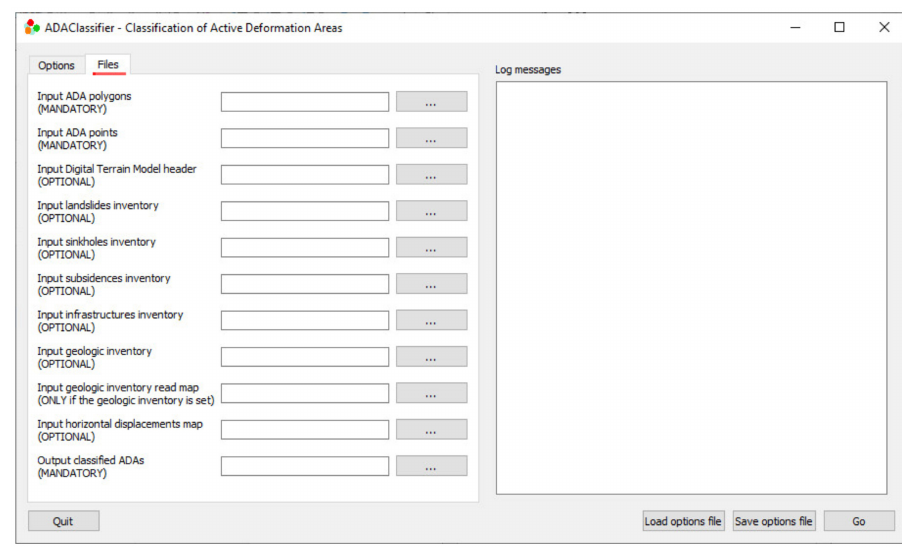
Figure 5. The ADAclassifier GUI (files